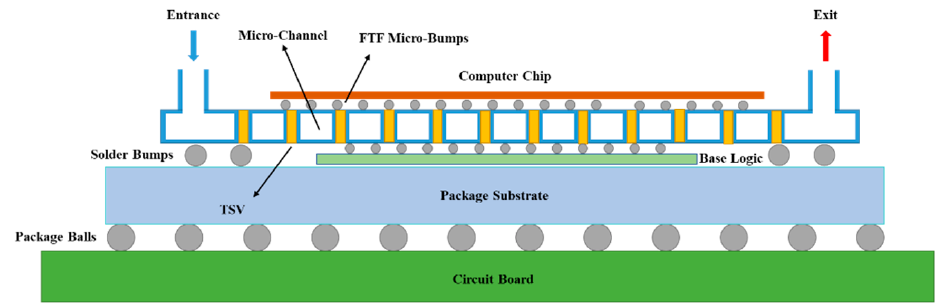
Figure 1. Schematic diagram of the 3D integrated chip structure with embedded cooling micro-channels.